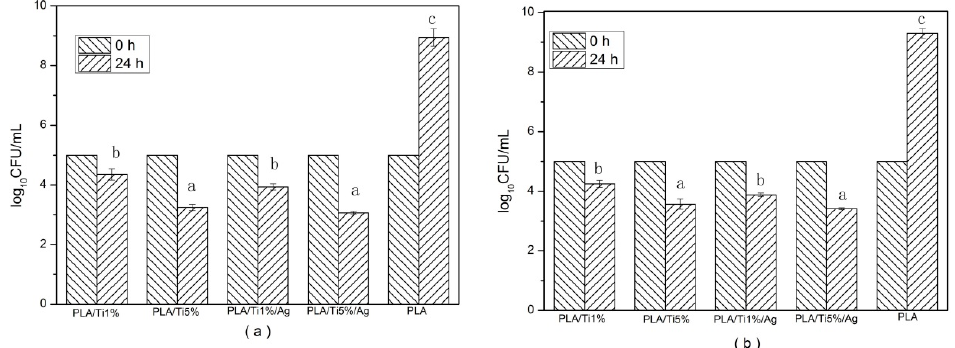
Figure 7. Antimicrobial activity of pure PLA and PLA nano-blend films. ( a ) E. coli and ( b ) Listeria monocytogenes . Values followed by different superscript letters (a–c) in the same column were significantly different ( p < 0.05), where a is the lowest value.